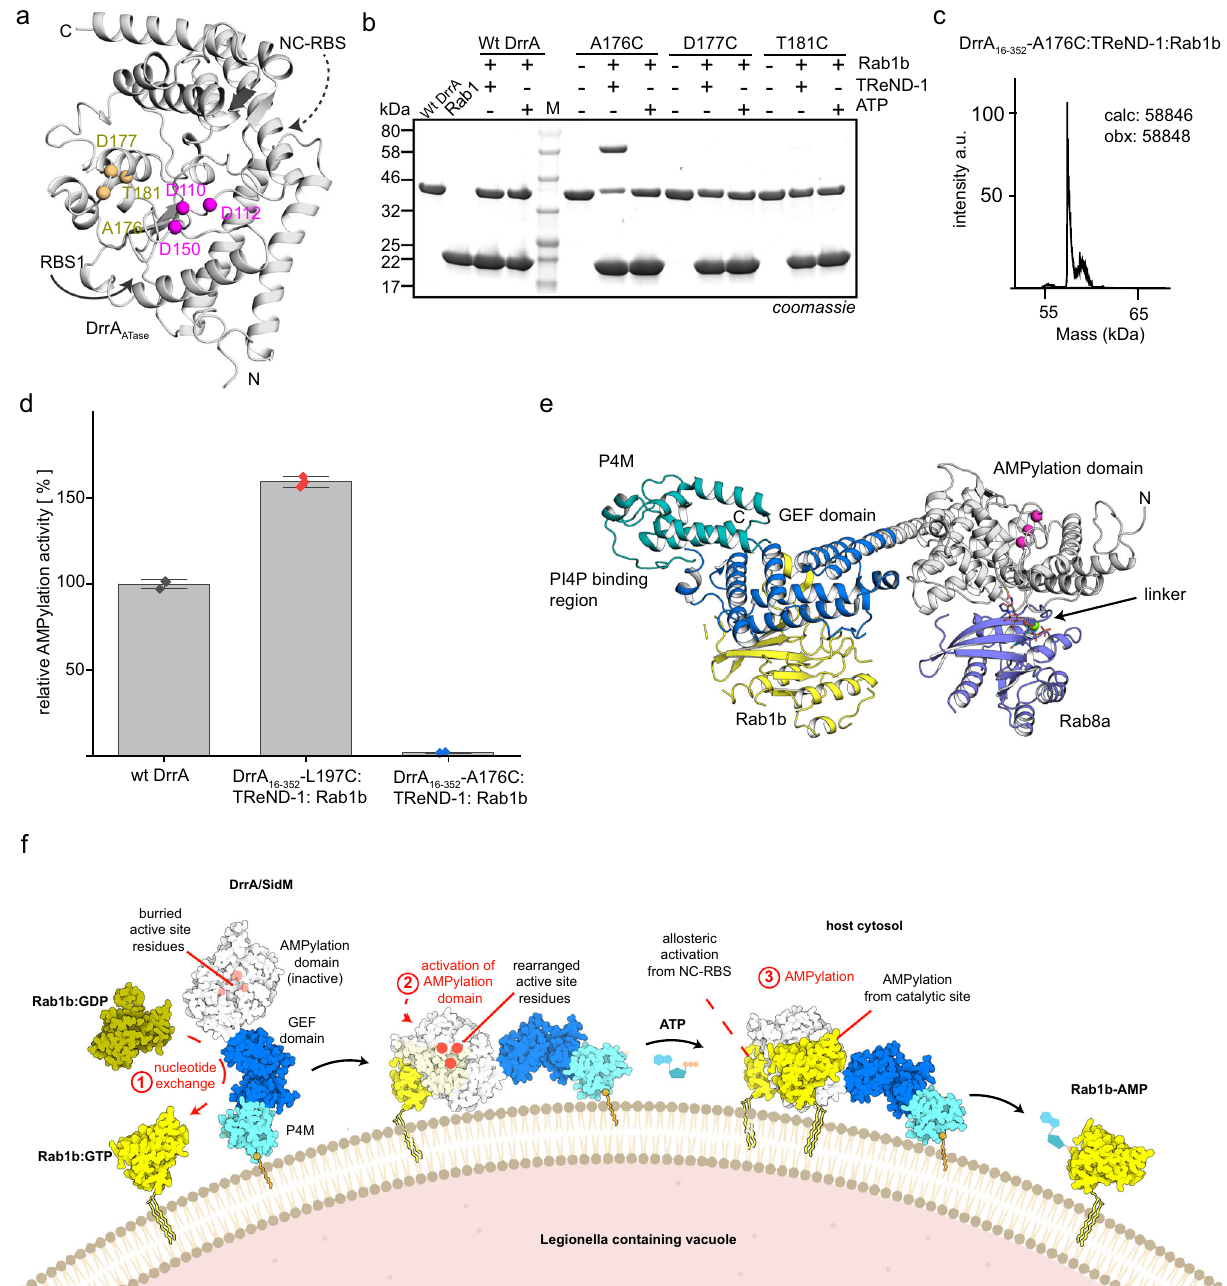
Fig. 5 Formation of the DrrA:Rab complex in RBS1. a Cys substitution sites (A176, D177 and T181, light orange) in DrrA ATase . Pink spheres represent the catalytic centre of DrrA ATase . RBS1 indicates the conventional site, which contains the catalytic centre. NC-RBS represents the non-canonical site, which is located at the back face of the catalytic centre. b SDS-PAGE shift analysis of DrrA:TReND-1:Rab1b complex formation in the catalytic side (RBS1). c Intact mass spectrometry analysis of the DrrA 16-352 -A176C:TReND-1:Rab1 complex (a.u.: arbitrary units). d AMPylation activity comparison of wt DrrA 16-352 and DrrA:TReND-1:Rab1 complexes using time-resolved tryptophan fl uorescence. Data are means ± SEM from three independent experiments. The k cat / K M value of wt DrrA is 8.0 × 10 5 M − 1 s − 1 (± 2.0 × 10 4 M − 1 s − 1 ). e Composite model of DrrA produced from the following crystal structures PDB: 6YX5,